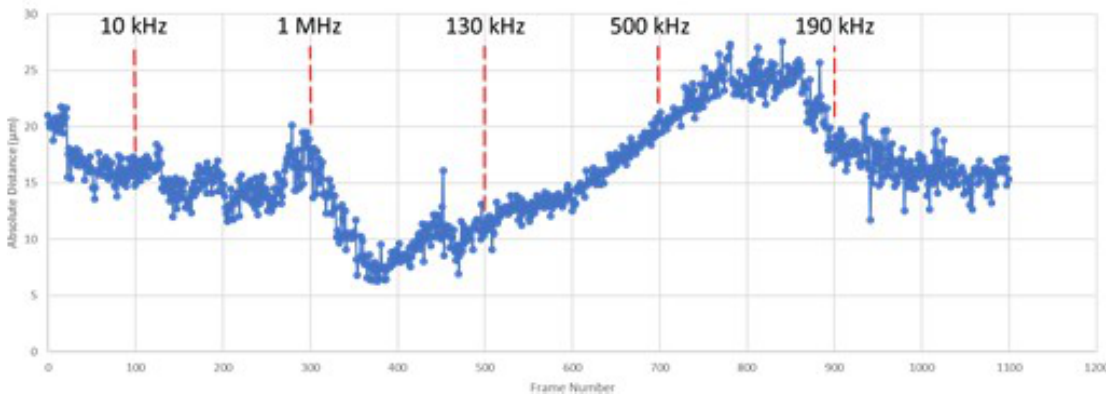
Figure 6. Average absolute distance from center by frame (Trial 1).